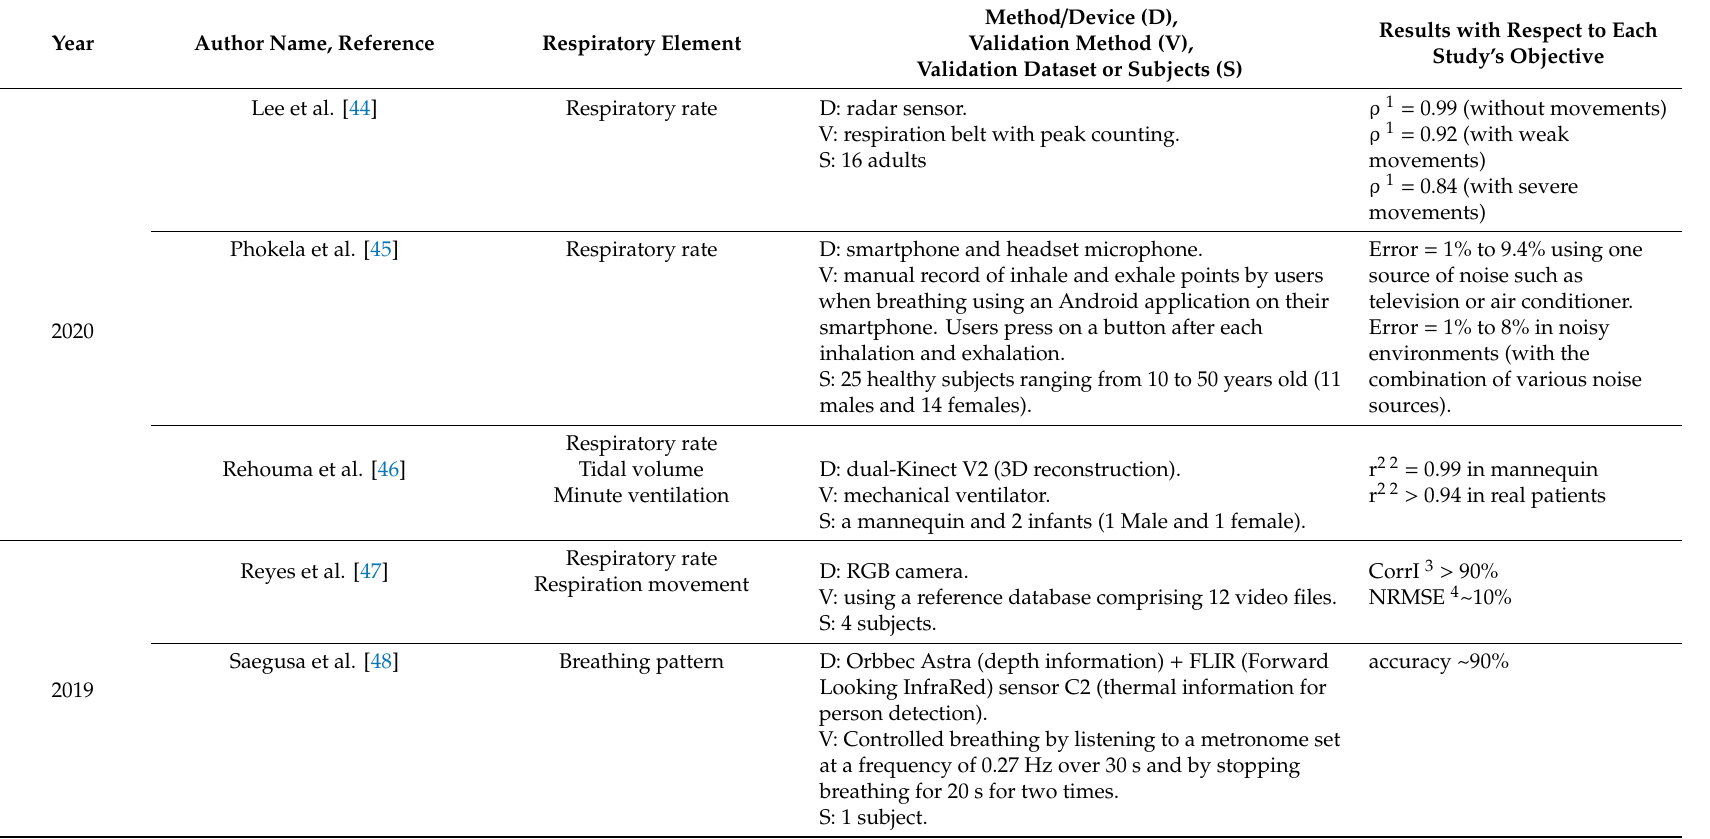
Table 1. Overview of some recent research in respiratory assessment over the four last years (from 2020 to